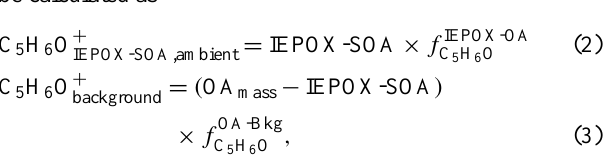
Figure 6. Time series of ambient f OA , gas-phase IEPOX, monoterpenes, and isoprene in DC3 aircraft measurement. Average f C C 5 H 6 O from regions strongly impacted by urban and biomass-burning emissions and MT emissions are also shown for reference. Two areas with grey background indicate the periods when f OA increases when monoterpene concentrations increase. C 5 H 6 O